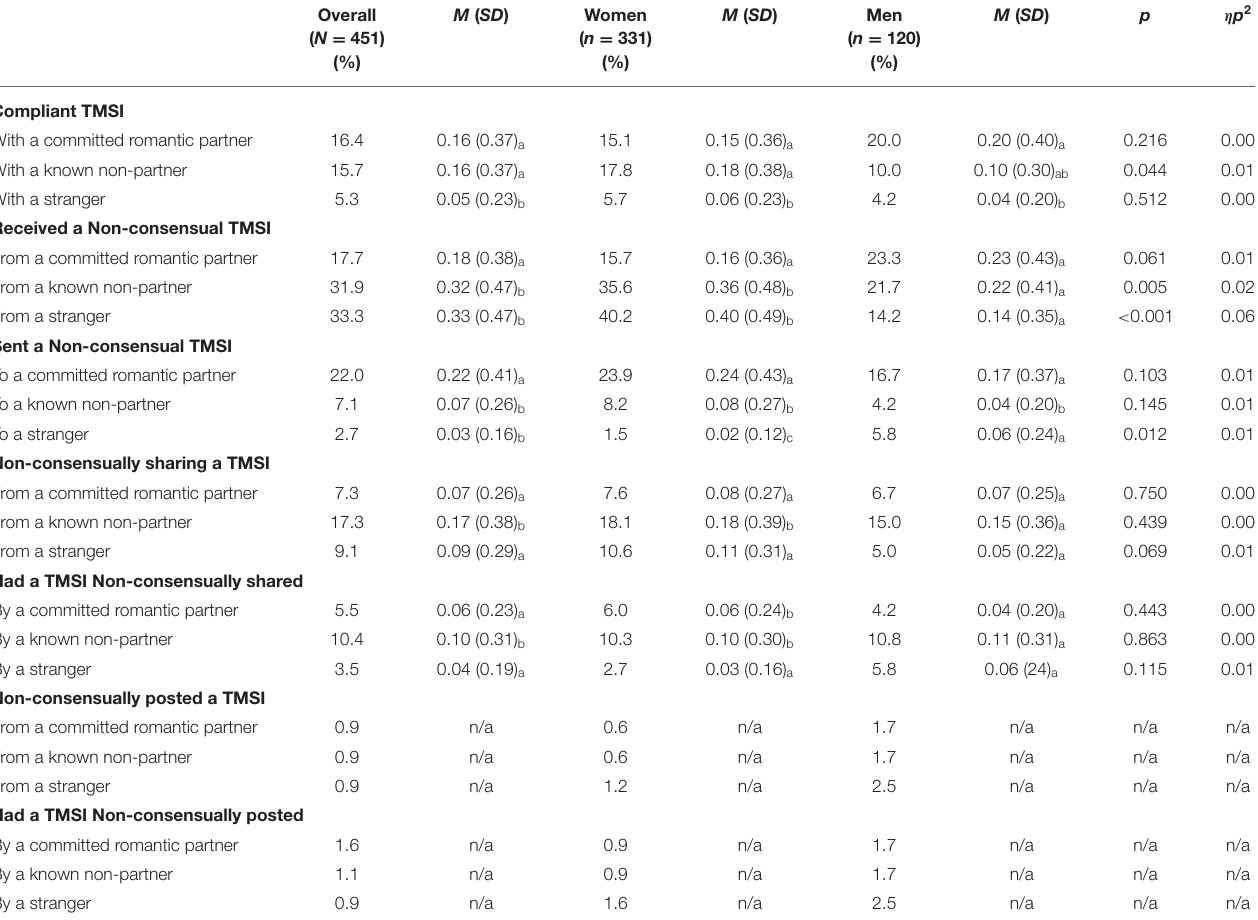
TABLE 3 | Prevalence of compliant and non-consensual TMSI experiences by gender.